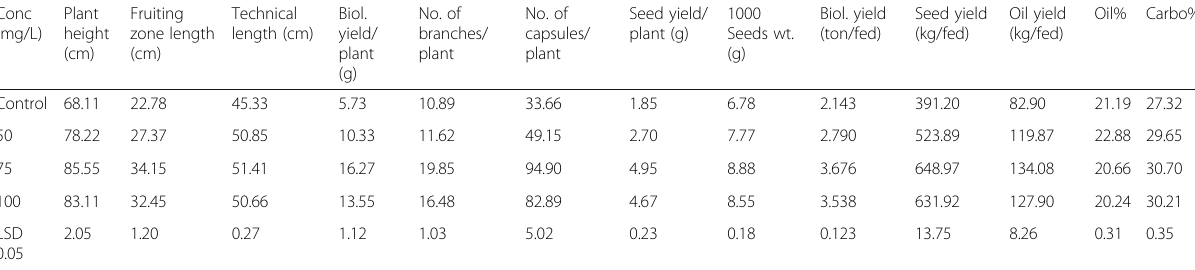
Table 10 Effect phenolic acid concentrations on seed yield, its components, and oil and carbohydrate percentages of flax plants grown under sandy soil conditions (data are means of two successive seasons) Conc Plant (mg/L) height